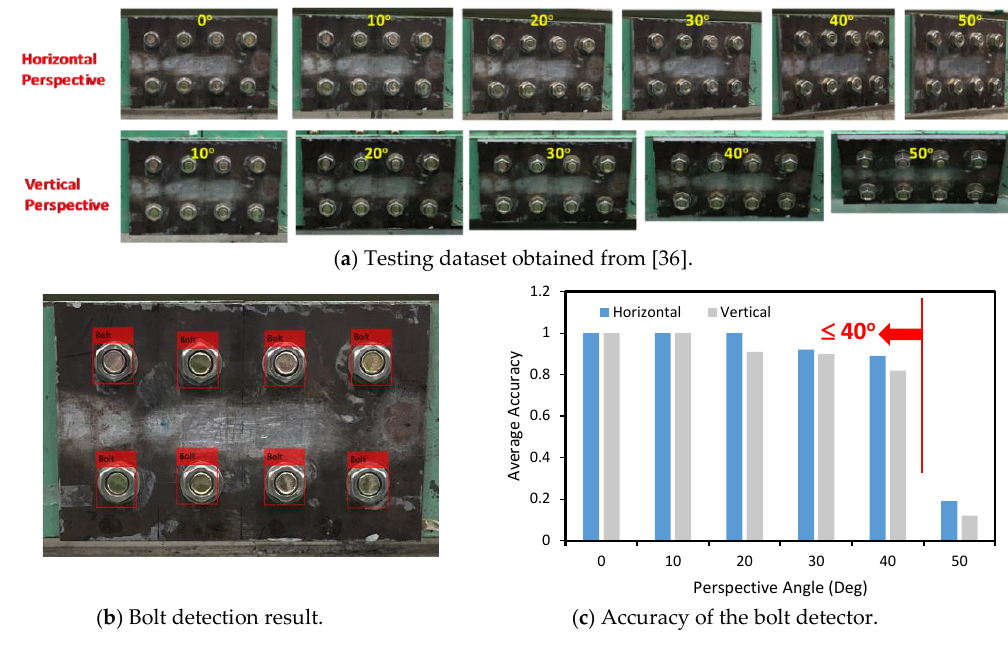
Figure 7. Testing the bolt detector on an existing realistic dataset.